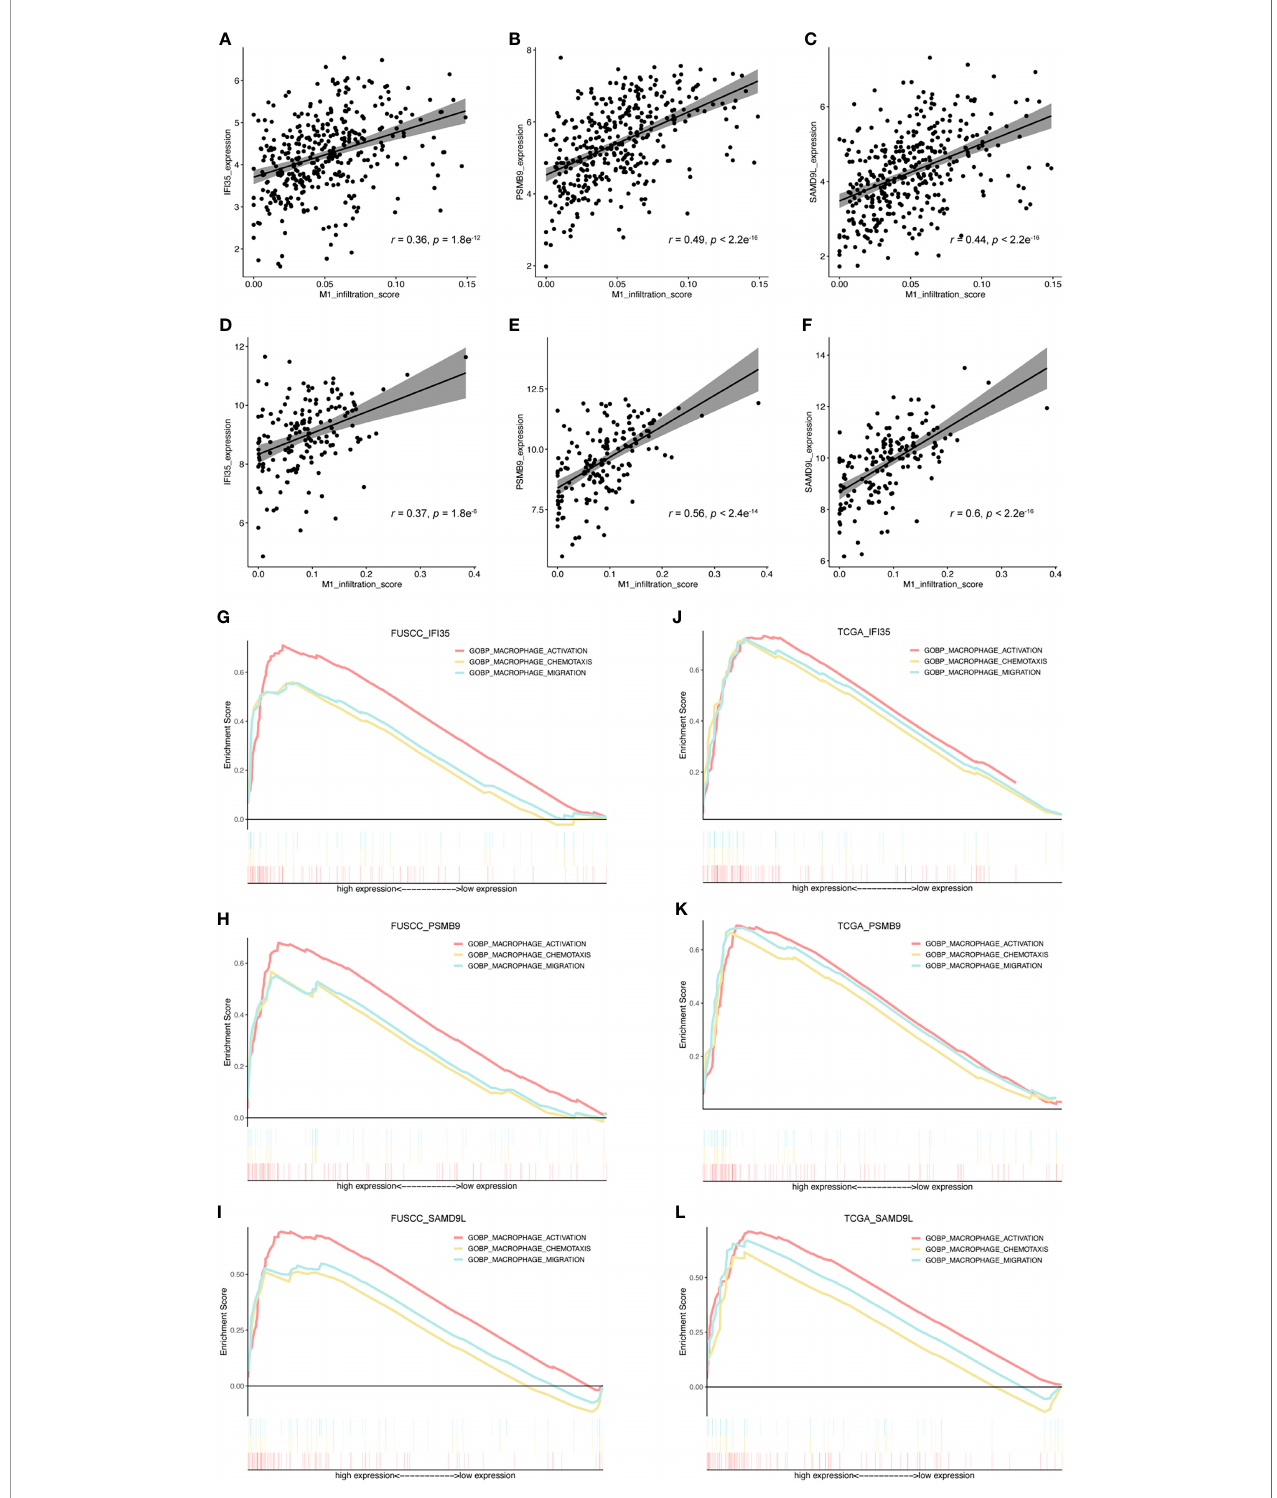
FIGURE 7 | Exploring the relationship between IFI35, PSMB9, and SAMD9L and M1 macrophages. (A – F) , The correlation between these 3 genes and M1 macrophage in fi ltration score. Cohorts, FUSCC (A – C) and TCGA (D, E) . (G – L) , 3 classical macrophage activation, chemotaxis, and migration gene sets were used to explore their relationship with gene expression of IFI35, PSMB9, and